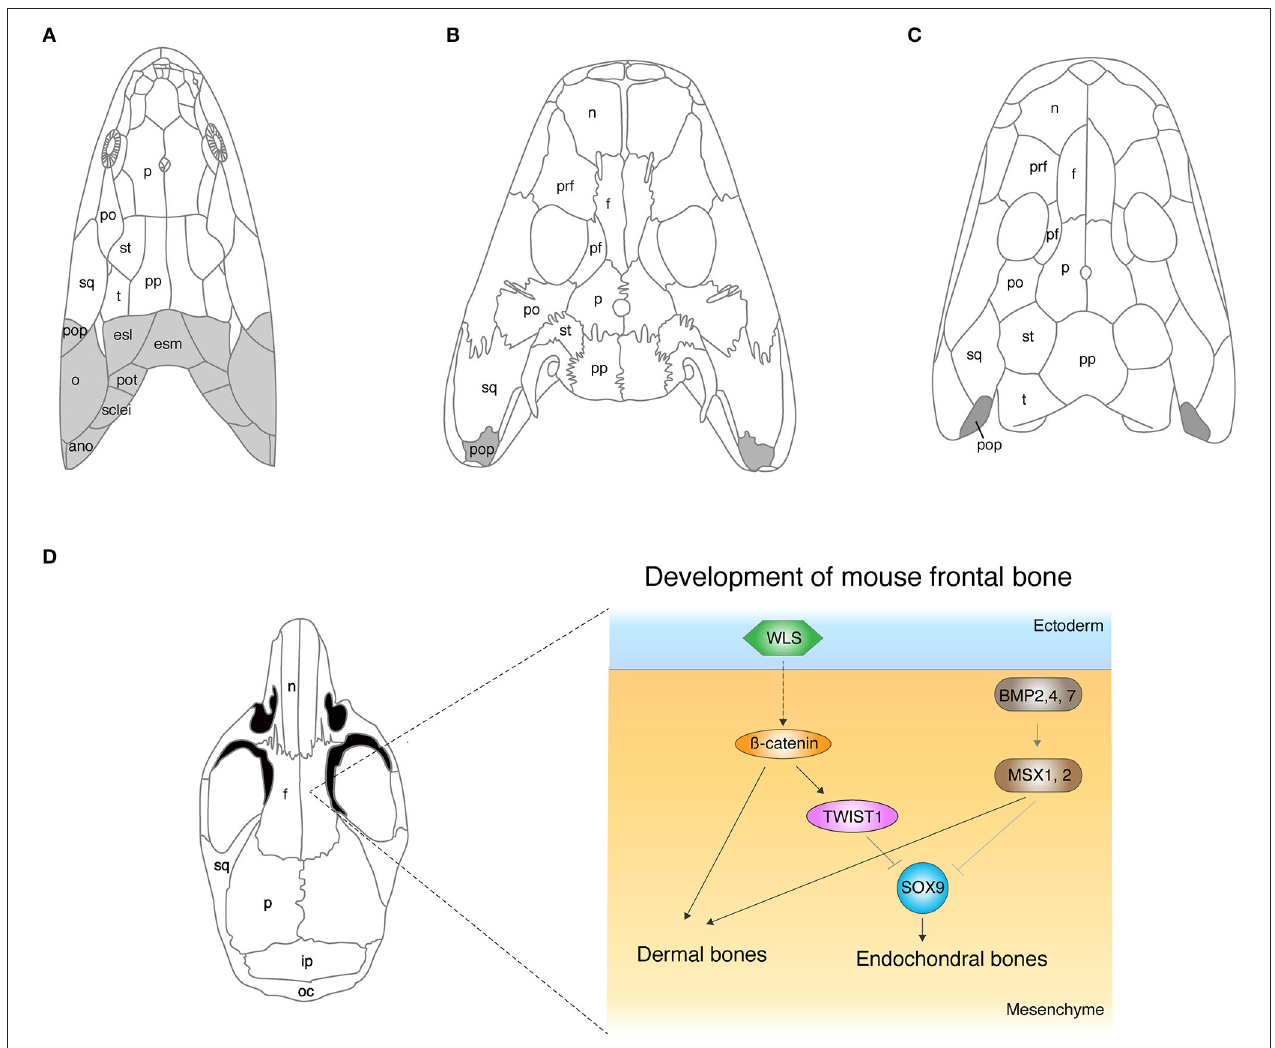
FIGURE 1 | The evolution of cranial dermal bones and the developmental mechanisms. (A–C) The skull roof of Eusthenopteron (A) , Acanthostega (B) , Ichthyostega (C) . (D) The developmental mechanisms of the frontal bone in mice. The molecules that initiate dermal differentiation from the ectoderm to the mesenchyme have not been identified yet, though the WNT signaling pathway is suggested to be involved ( Goodnough et al., 2014). ano, anocleithrum; esl, lateral extrascapular; esm, medial extrascapular; f, frontal; ip, interparietal; n, nasal; o, opercular; oc, occipital; p, parietal; pf, postfrontal; po, postorbital; pop, preopercular; pot, post-temporal; pp, postparietal; prf, prefrontal; st, supratemporal; sq, squamosal; sclei, supracleithrum; t, tabular. Illustrations in (A–D) are redrawn with permissions from Clack (2012), Jarvik (1980), and White et al.